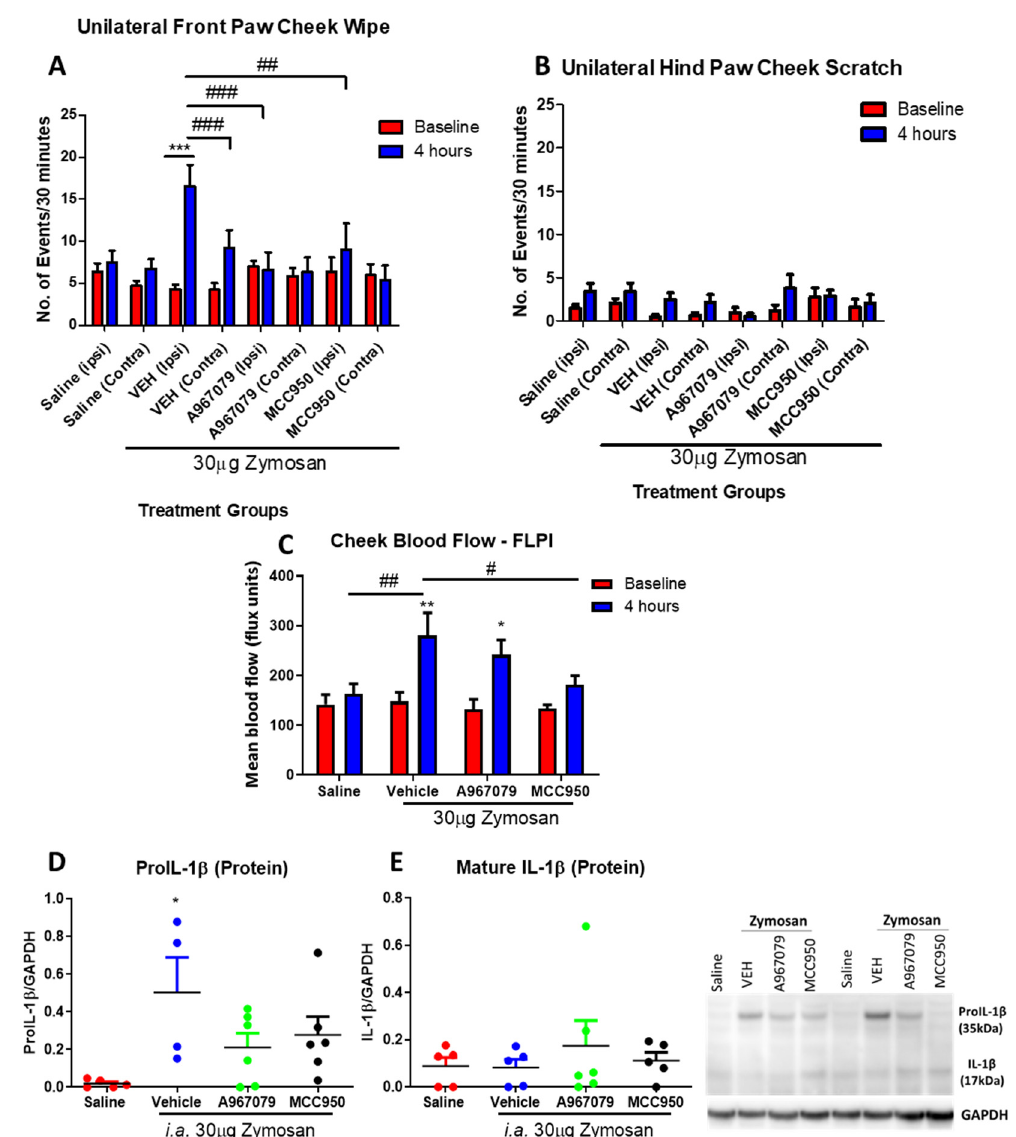
Figure 2. The distinct effects of a TRPA1 antagonist (A967079) or an NLRP3 antagonist (MCC950) on the observed spontaneous behaviors and blood flow in the acute 4 h zymosan model. Number of ( A ) unilateral front paw cheek wipe and ( B ) unilateral hind paw cheek scratch in response to saline or zymosan when pre-treated with vehicle (10% DMSO, 10% Tween-80 in saline), A967079 (100mg/kg, i.p.) or MCC950 (10mg/kg, i.p.), ( C ) cheek blood flow as measured by the FLPI, ( D ) Pro-IL1 β and ( E ) mature IL-1 β Western blots of the TMJ samples. Data represent mean ± SEM, n = 7 − 14 animals per group. Data analysed by two-way ANOVA with Bonferroni’s post hoc test. * p < 0.05, ** p < 0.01, *** p < 0.001 between saline vs. zymosan as indicated, # p < 0.05, ## p < 0.01, ### p < 0.001 between the indicated groups.